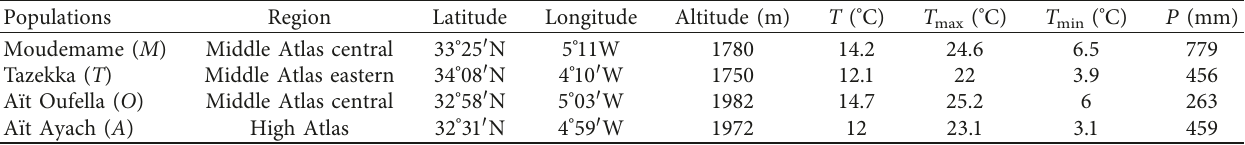
Table 1: Location and geographic characteristics of studied populations of Cedrus atlantica in